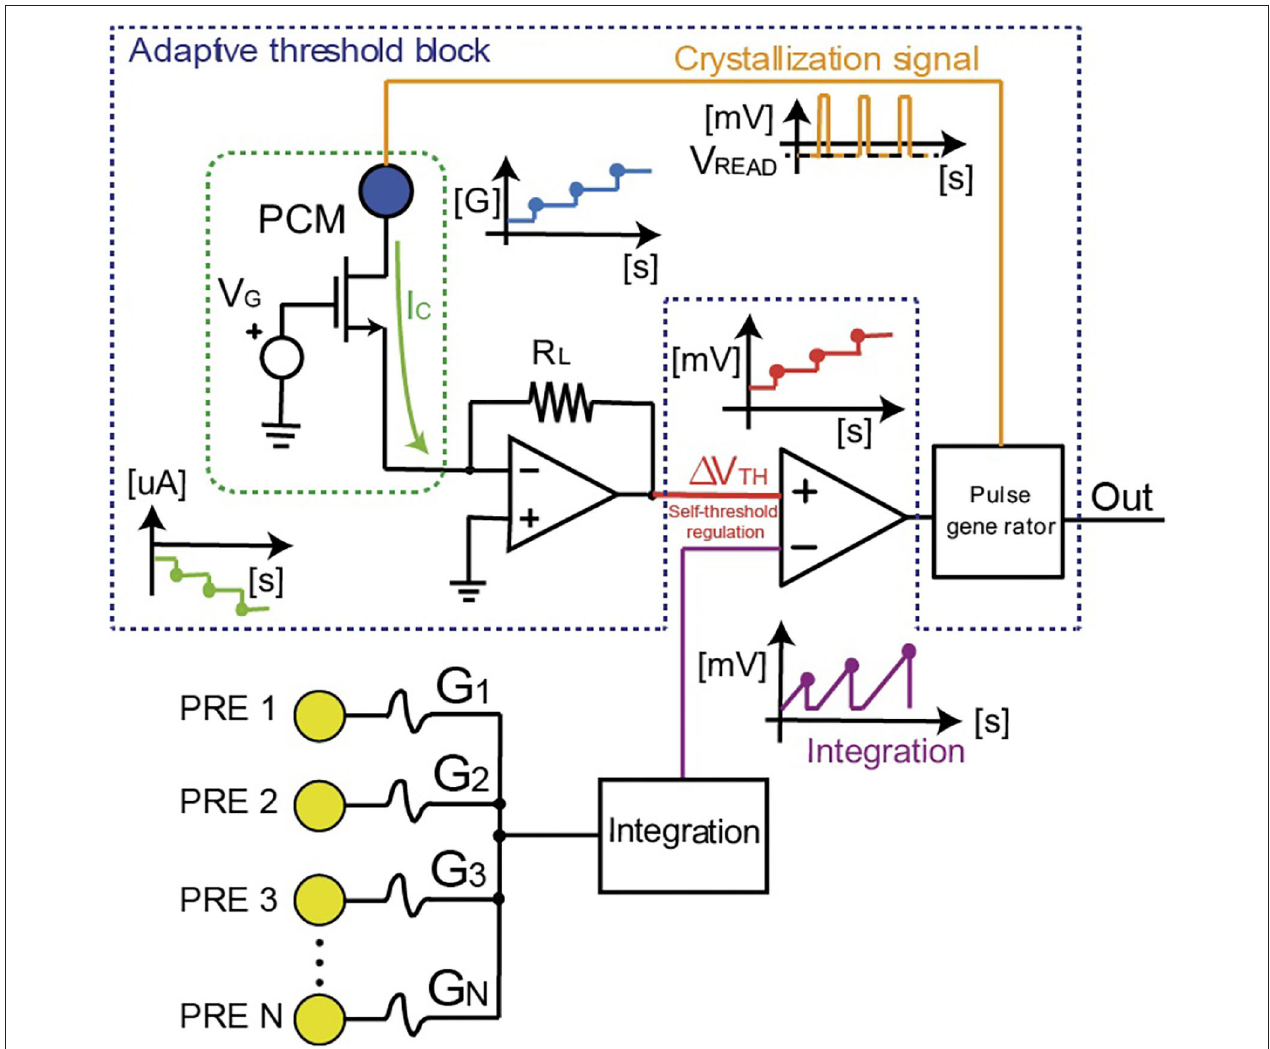
FIGURE 2 | Scheme of the homeostatic neuron with the control PCM device which regulates the internal threshold. The spike signals coming from other neurons (e.g., pre-synaptic neurons) are integrated (“Integration” block) using an Arduino microcontroller (2 or Mega2560 in the measurements we performed). Arduino also manages the fire activity when the threshold of the neuron is overcome. When this happens, two signals are generated: (i) the “Out” response of the neuron and (ii) the crystallization pulse for the gradual increase of the PCM conductance. In this way the internal threshold V TH of the neuron